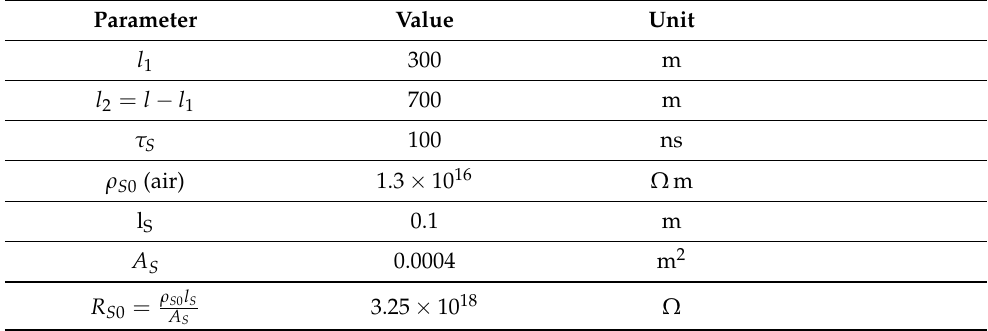
Table A3. Short-circuit parameters.